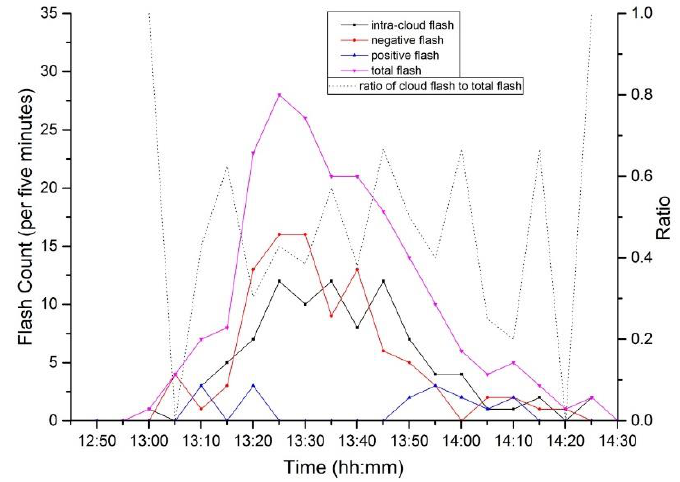
Figure 5. Flash count per 5 min during the thunderstorm.